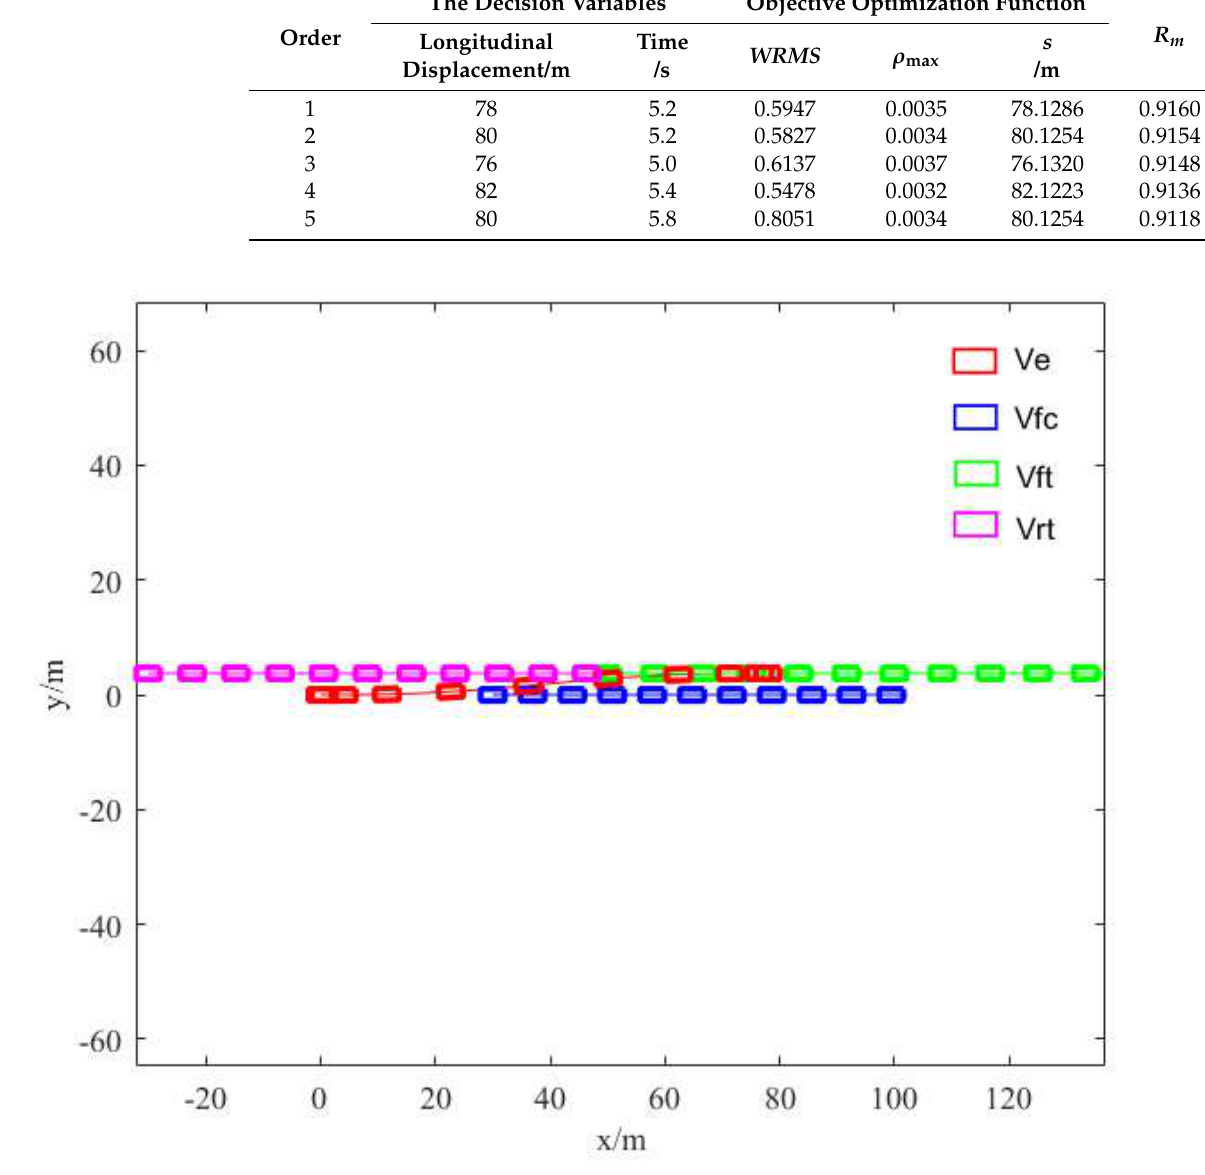
Figure 8. Lane changing trajectories of the ego vehicle and other surrounding vehicles. In Equation (1), the lateral trajectory is a function of the longitudinal displacement x . The lateral velocity and acceleration can be obtained by Equation